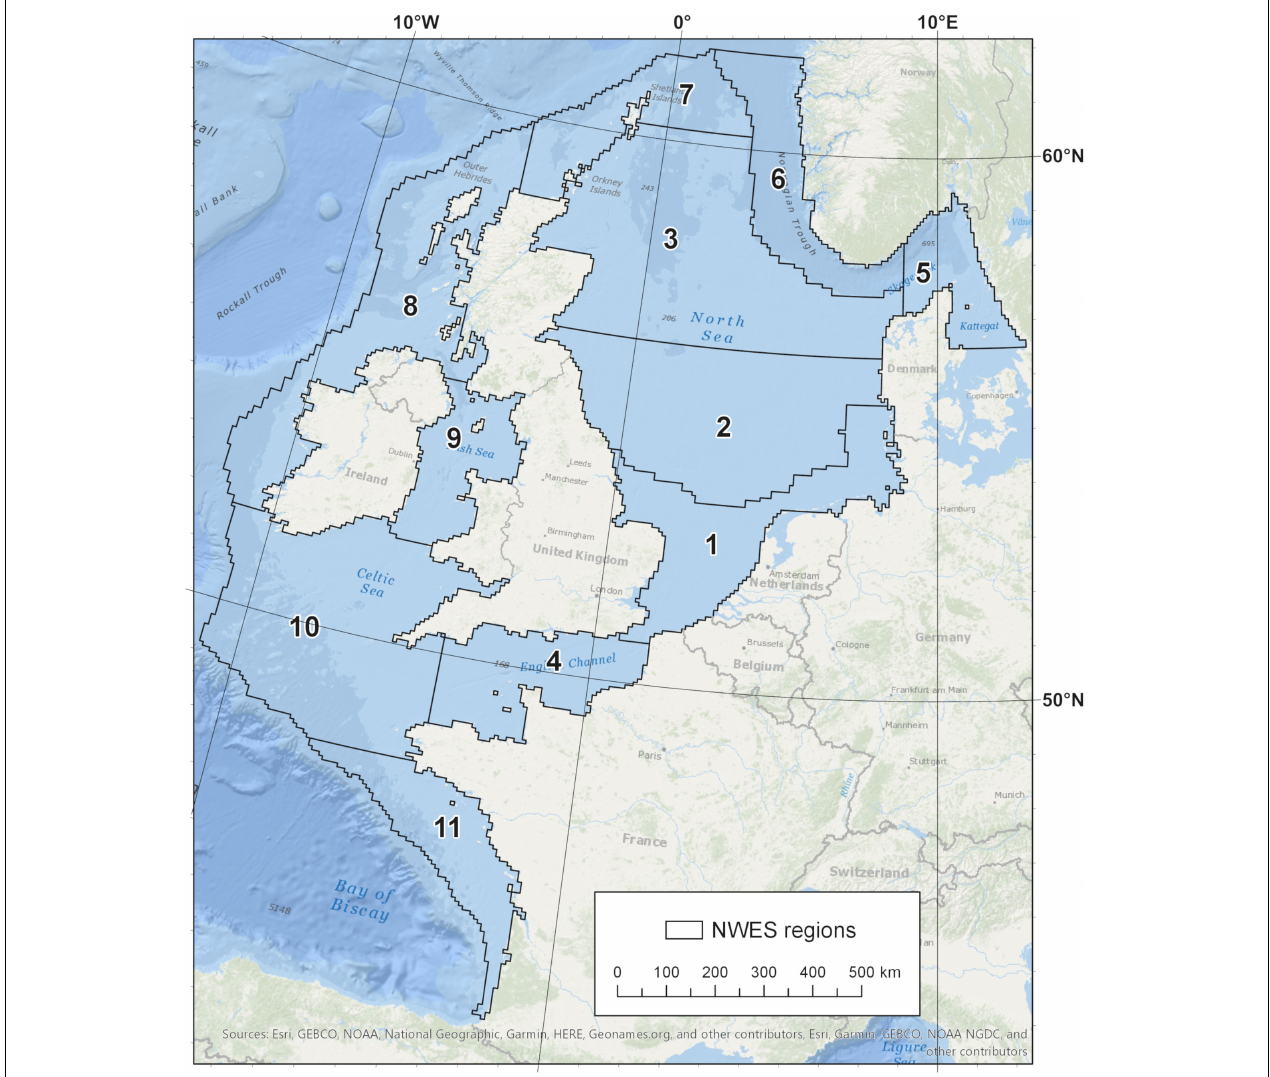
FIGURE 1 | A map of the northwest European continental shelf. Numbers indicate the following regions, referred to in this study. 1: Southern North Sea, 2: Central North Sea, 3: Northern North Sea, 4: English Channel, 5: Skagerrak and Kattegat, 6: Norwegian Trench, 7: Shetland Shelf, 8: Irish Shelf, 9: Irish Sea, 10: Celtic Sea, 11: Armorican